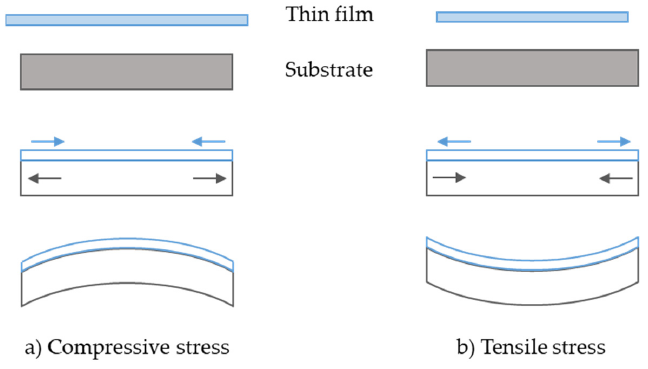
Figure 2. Imaginary sequence showing the building of ( a ) compressive and ( b ) tensile stress in thin films deposited on a thick substrate.